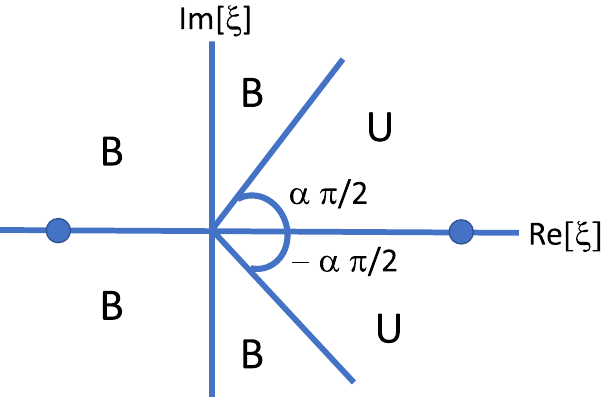
Figure 4. Asymptotic stability for the amplitudes φ 1 ( z ) , φ 2 ( z ) for the fractional PT dimer system (22). Here, (σ 2 U unbounded , B bounded , and ξ 1 ) z 2 α . The dots denote the position of our two phases, ≡ ≡ = − phase (σ